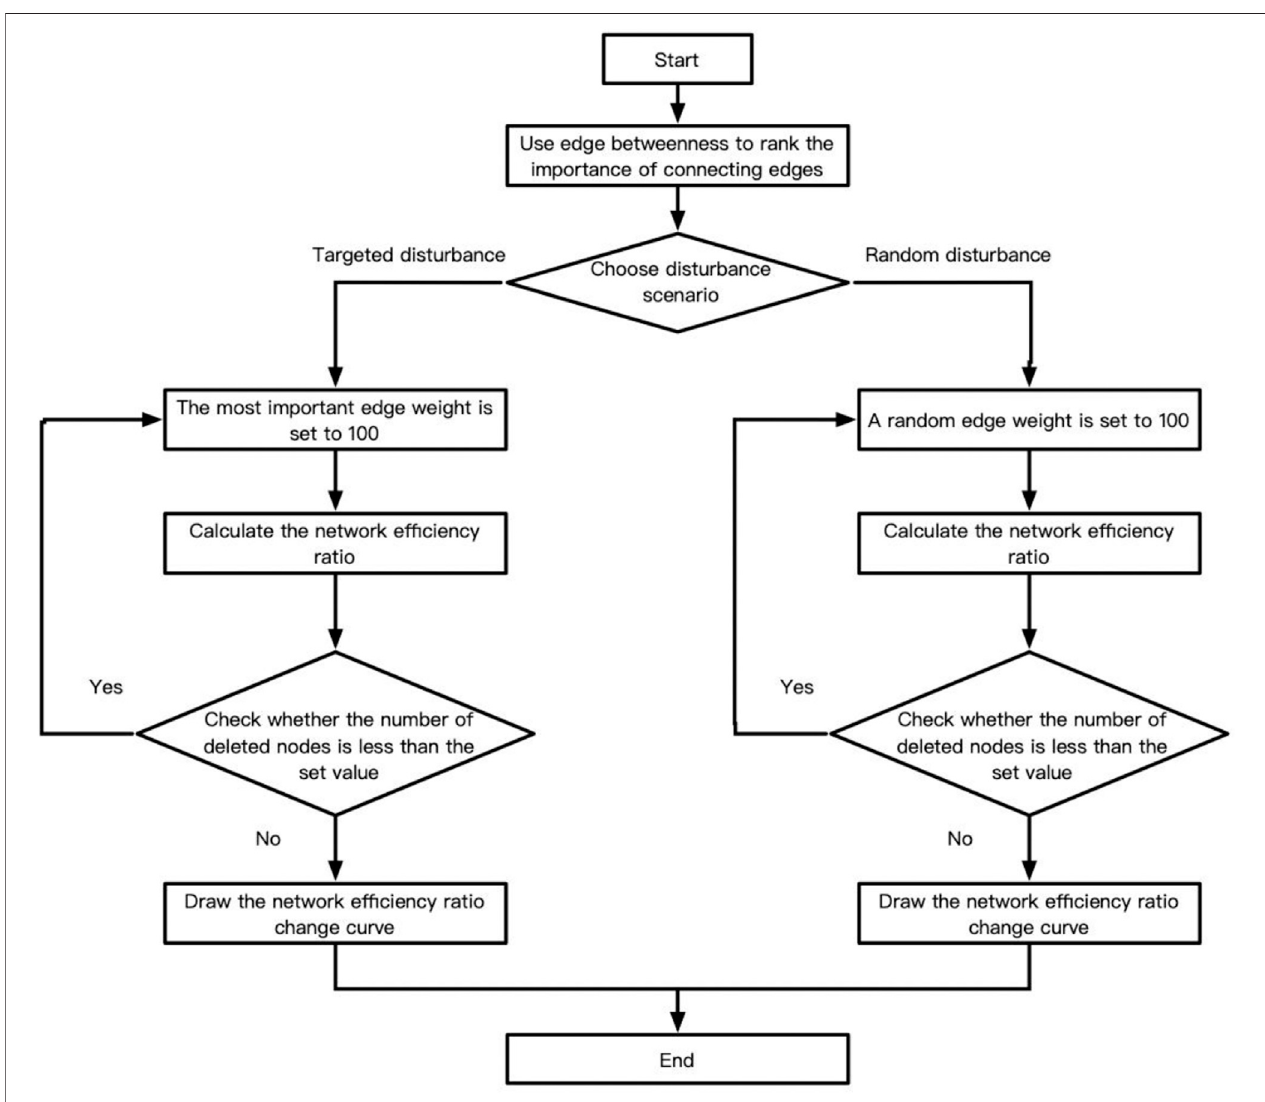
FIGURE 6 | Disturbance model two simulation algorithm fl ow